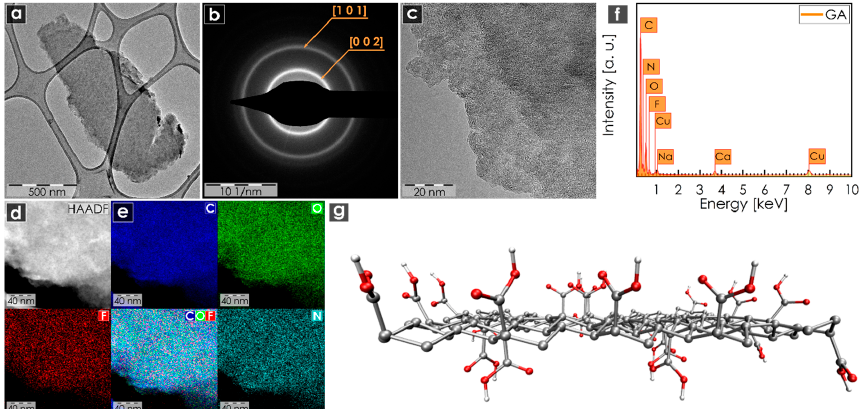
Figure 2. ( a ) High-resolution TEM (HRTEM) image of a GA sample; ( b ) selected area electron diffraction (SAED) analysis of a GA sample; ( c ) high-magnification HRTEM image of a GA sample; ( d ) dark-field HRTEM image used for EDS chemical mapping; ( e ) EDS elemental mapping of GA sample (on a Cu grid), including carbon, oxygen, fluorine and nitrogen atoms; ( f ) energy-dispersive X-ray (EDAX) spectrum of a GA sample; ( g ) optimized structure of GA. The molecular structure of GA was visualized using VMD software (version 1.9.3) [51]. Scale bars were unified from the graphical point of view in order to possess better visibility.